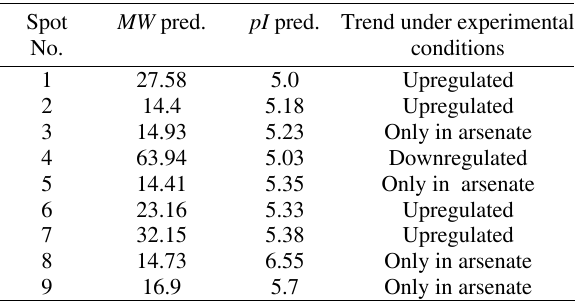
Table 1 . Description of differentially expressed proteins in the cells of P. fluorescens biotype F